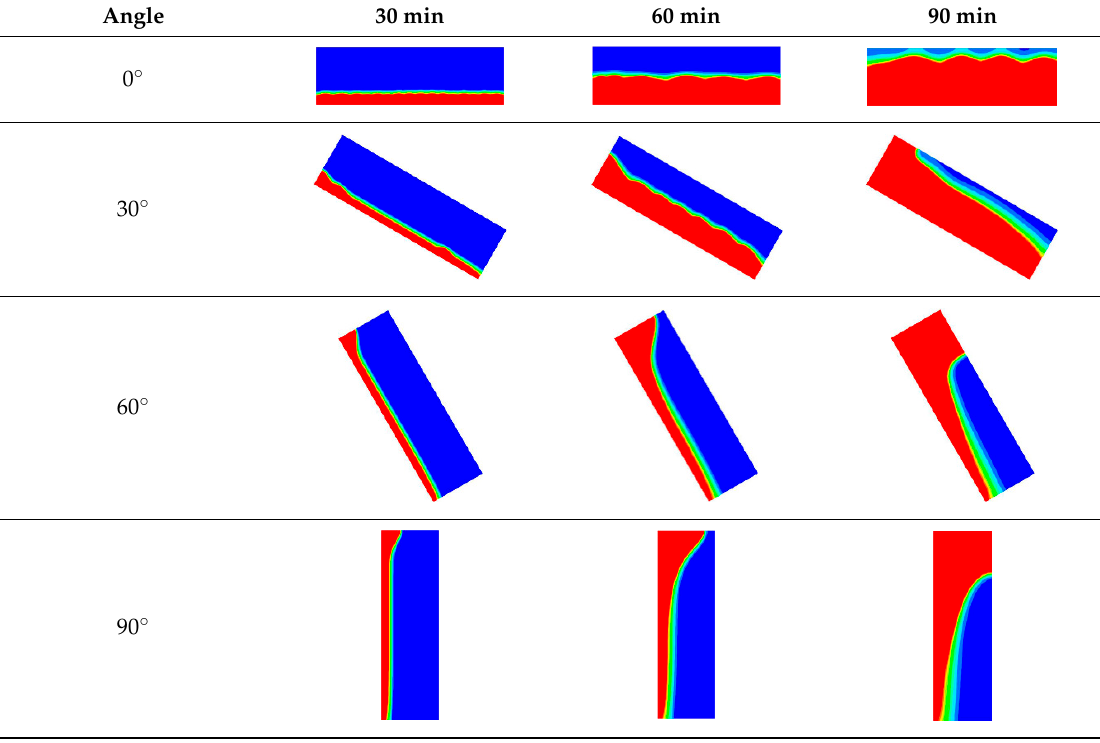
Table 3. Comparison of the numerical results of solid-liquid interfaces with different inclination angles at three selected times.